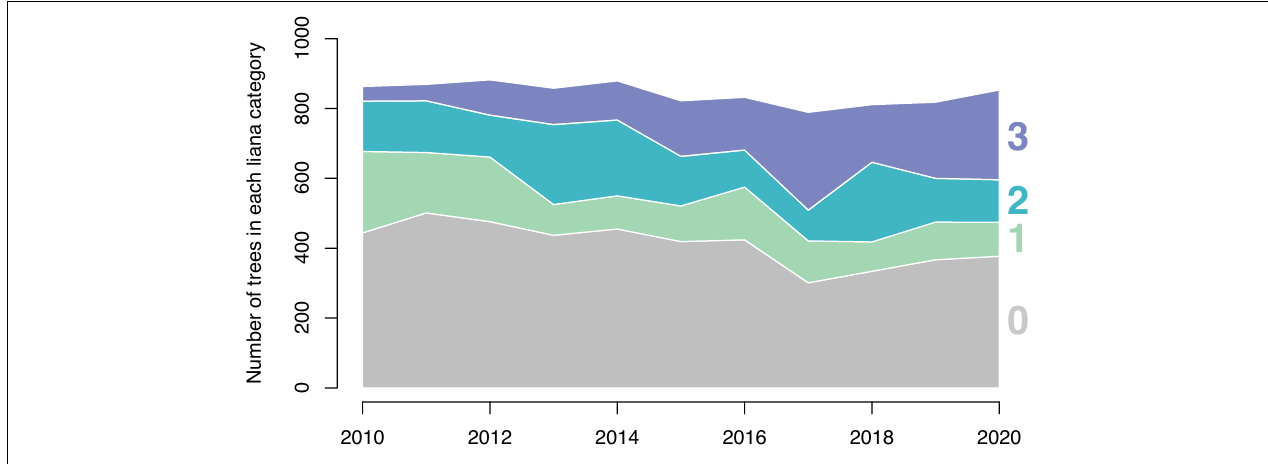
FIGURE 1 | The change in the number of trees per liana presence category by year. The overall number of trees in the study changes little among years. The number of trees in categories 2 and 3 increase while the number of trees in categories 0 and 1 decrease over time. This analysis omits trees under 10 cm DBH which were first observed in